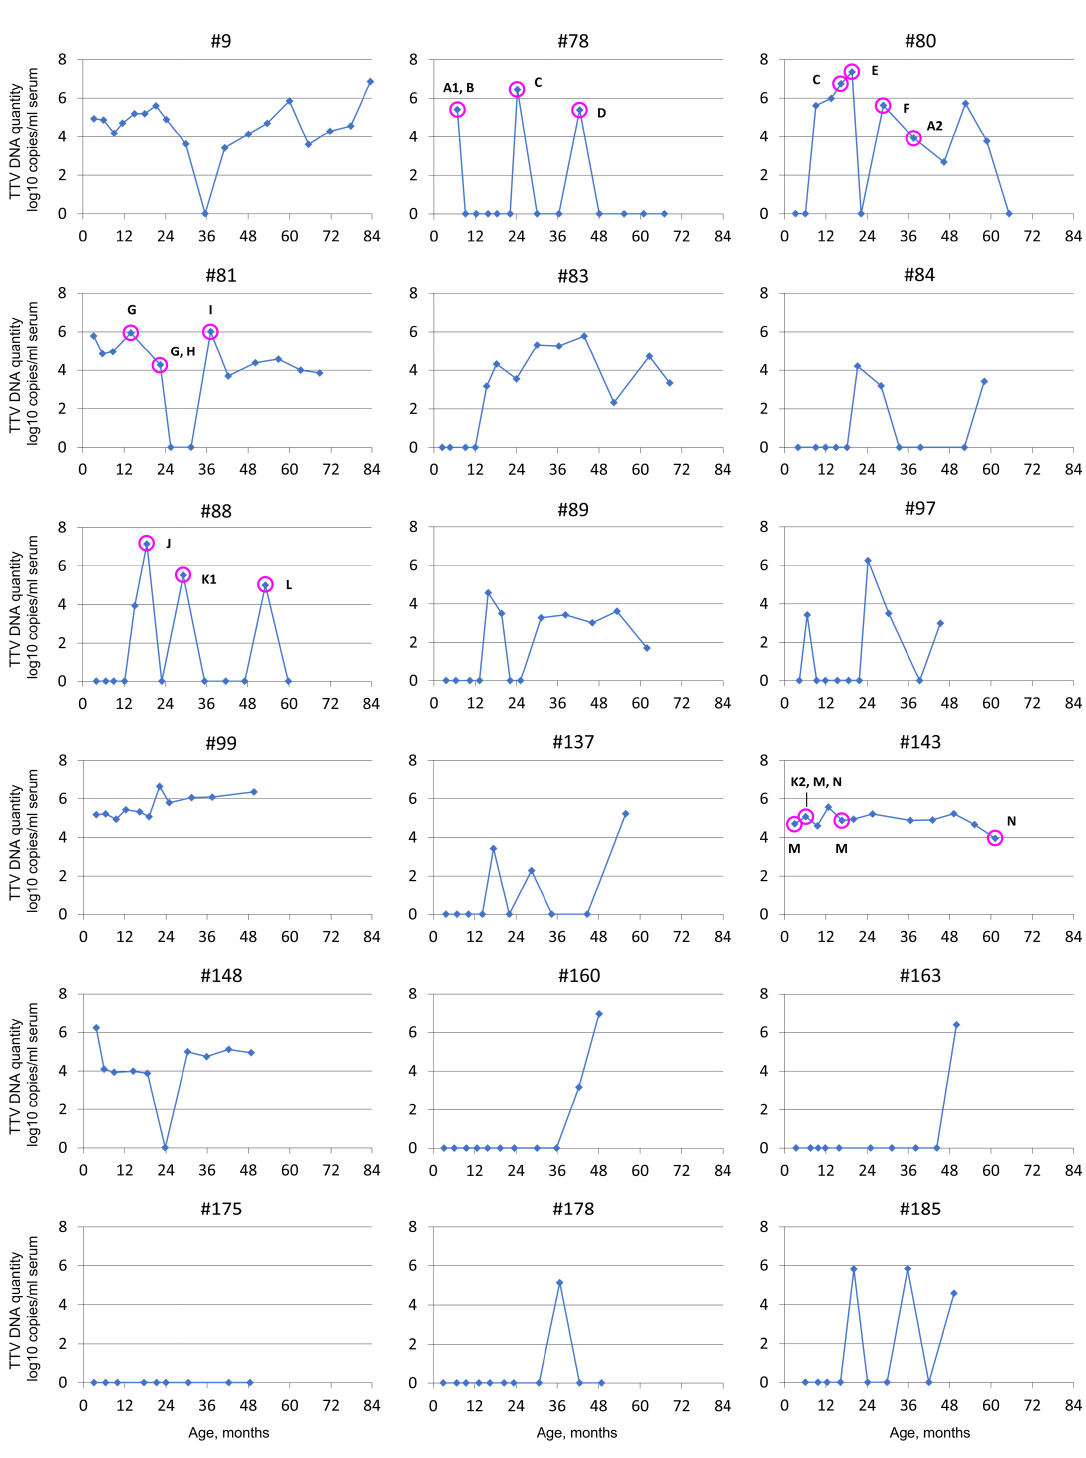
Figure 3. Serum TTV DNA quantity fluctuations in children ( n = 18) followed up for 4 to 7 years. The TTV strains present in a total of 17 selected samples (indicated with purple rings) of five children were further analyzed with multiplex PCR and sequencing. The different TTV strains are labeled with different letters to facilitate easy differentiation of the types in the figure. NB, the letters are in alphabetical order and do not correlate with any ICTV or other classifications. A1 and A2 types are, on the nucleotide level, 95.2–96.1% similar to each other, and K1 and K2 are 95.0–95.2% similar. Type N is 90.5–90.9% similar to K1 and 88.3–88.6% similar to K2, and therefore defined as a different strain. Other strains are 75% or less similar to each other. See Figure 4, phylogenetic tree, for more